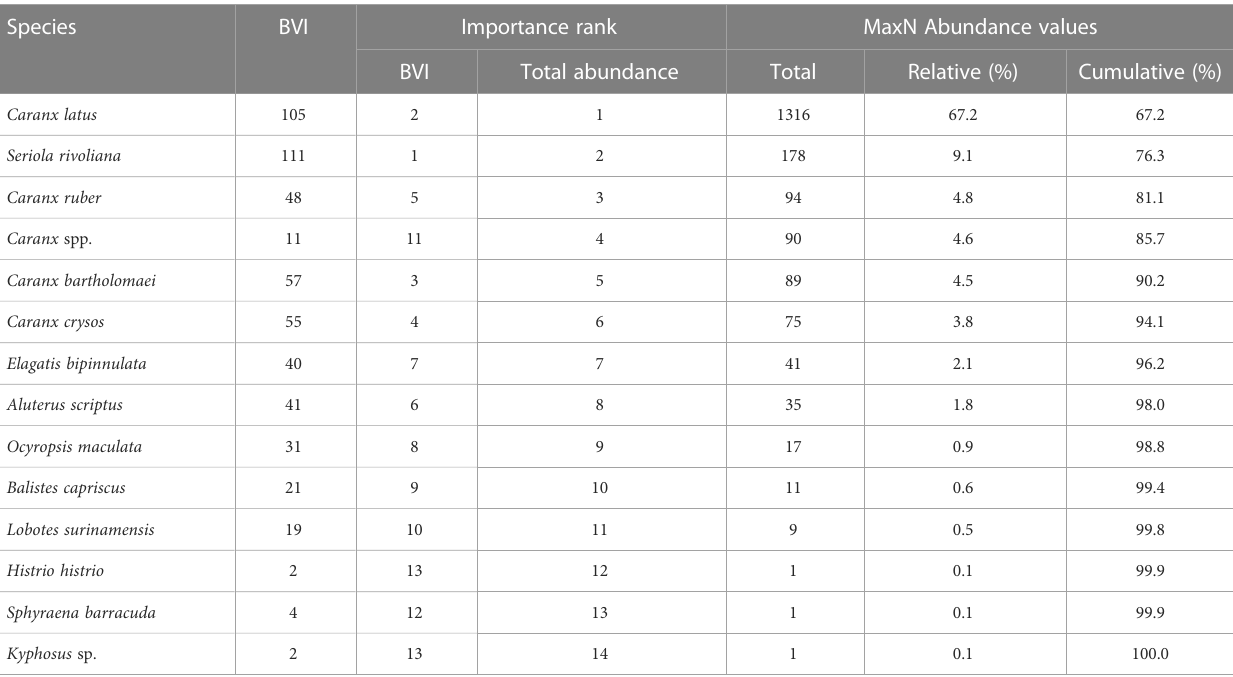
TABLE 2 Sanders biological value index (BVI) for species observed under pelagic sargassum, based on the total points obtained per species from 35 underwater surveys. Species BVI Importance rank MaxN Abundance values BVI Total abundance Total Relative (%)